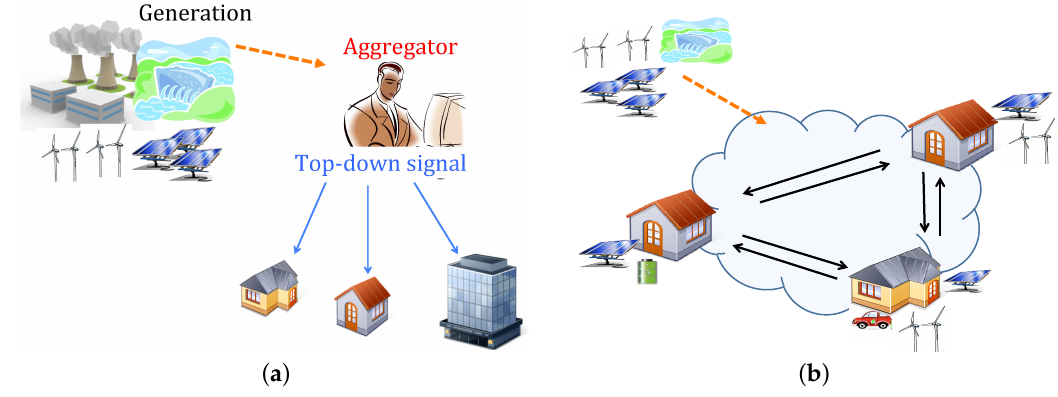
Figure 1. Demand management paradigms implementations: ( a ) demand management from the supply-side ; and ( b ) demand management from the demand-side